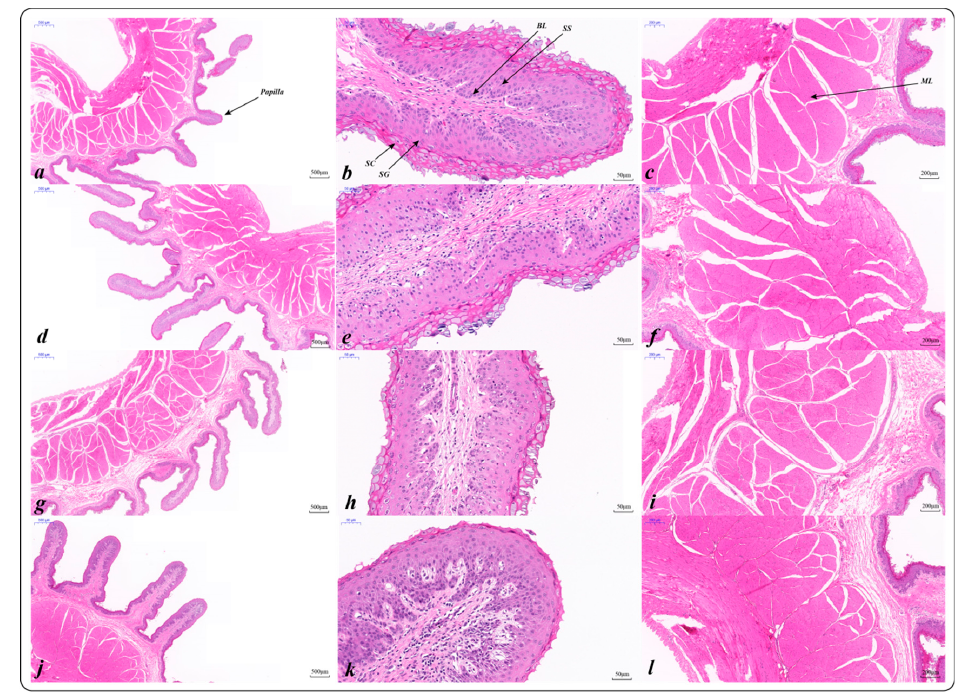
Figure 2. Histological characteristics of rumen epithelium of Tibetan sheep at different ages: 4 months ( a – c ); 1.5 years ( d – f ); 3.5 years ( g – i ); 6 years ( j – l ); SC: stratum corneum; SG: stratum granulosum; SS: stratum spinosum; BL: basal layer; ML: muscular layer. 2.3.2. Ultrastructural Characteristics of Rumen Epithelium (TEM) To further observe the ultrastructure of the rumen epithelium, the rumen epithelium